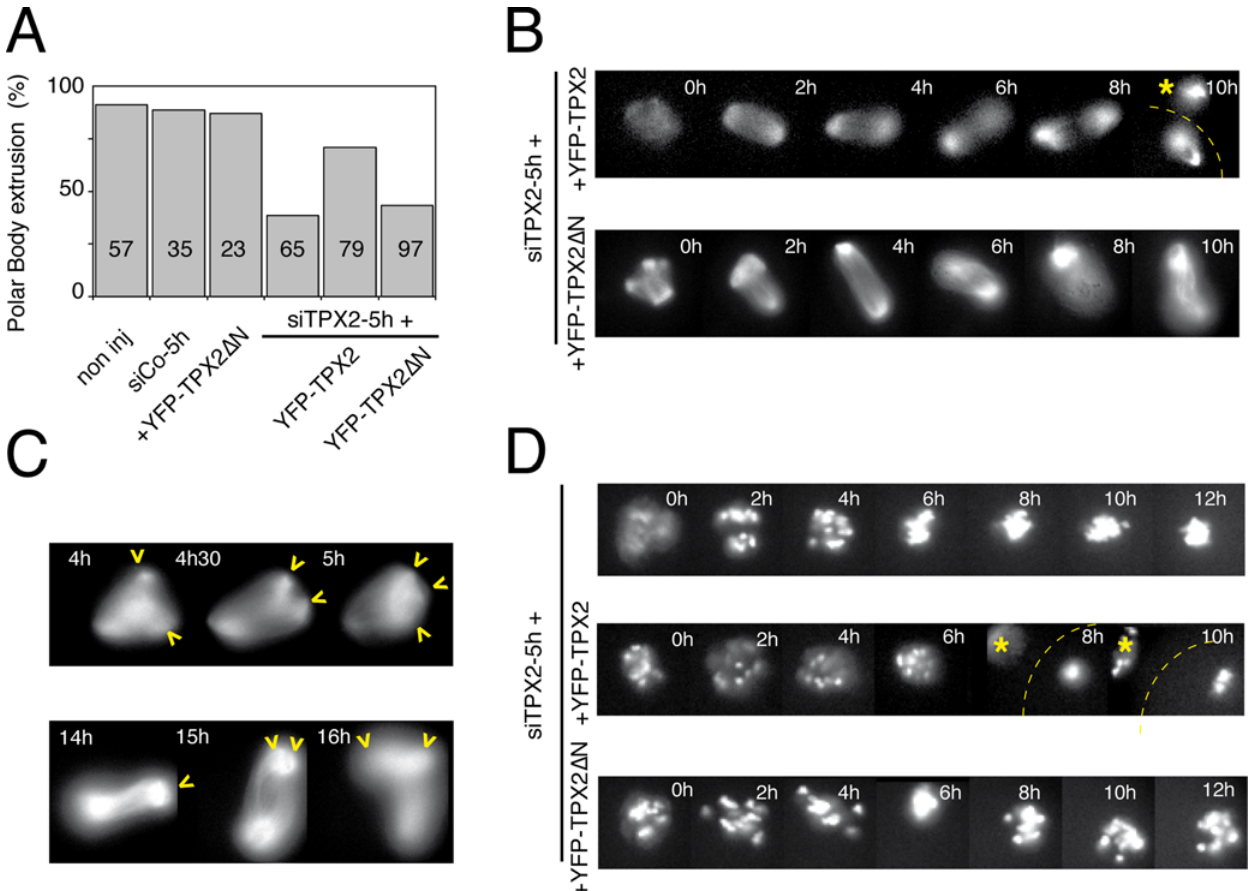
Figure 5. TPX2 activity relies on two distinct protein domains in the oocyte. A: Percentage of polar body extrusion in different experimental conditions. Non-injected, siTPX2-5h, YFP-TPX2 D N injected oocytes as well as oocytes co-injected with siTPX2-5h and YFP-TPX2 or YFPTPX2 D N were analyzed. The total number of oocytes examined is indicated in each bar. B: Representative sequence of fluorescent images showing the microtubules organization in siTPX2-5h injected oocytes, which were co-injected either with YFP-TPX2 (upper panel) or YFP-TPX2 D N (lower panel). Both YFP-TPX2 and YFP-TPX2 D N rescued the spindle collapse. Asterisk indicates the polar body and the dotted line shows the outline of the oocyte. C: Representative fluorescent images of siTPX2-5h-injected oocytes co-injected with YFP-TPX2 D N show spindle poles splitting (arrowheads). D: Representative sequence of fluorescent images showing the chromosomes siTPX2-5h injected oocytes expressing RFP-histone H2B alone (top panel), co-injected with either YFP-TPX2 (middle panel) or YFP-TPX2 D N (bottom panel). The asterisk indicates the polar body and the dotted line shows the outline of the oocyte. Times are relative to the GVBD.